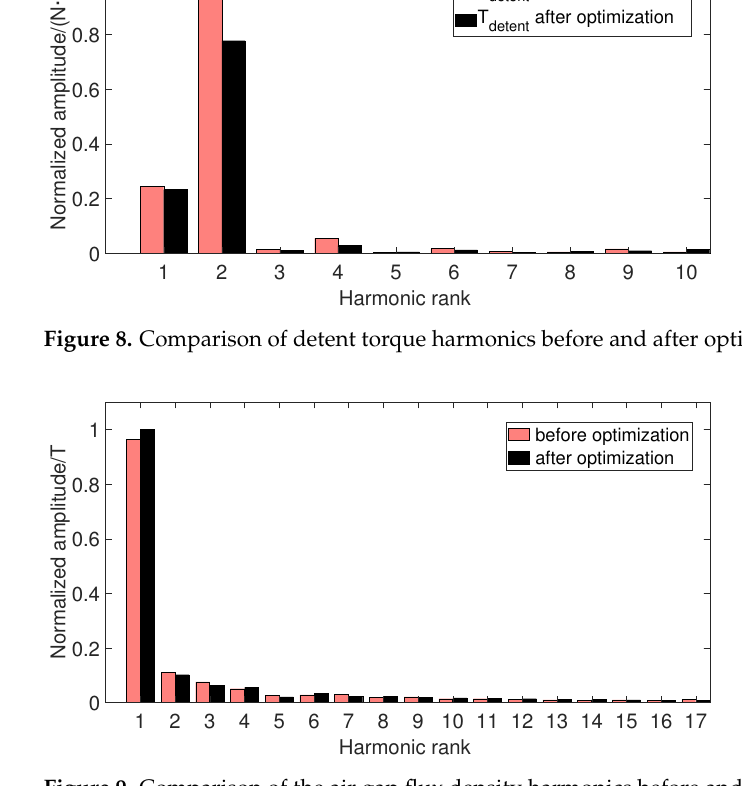
Figure 9. Comparison of the air gap flux density harmonics before and after optimization.